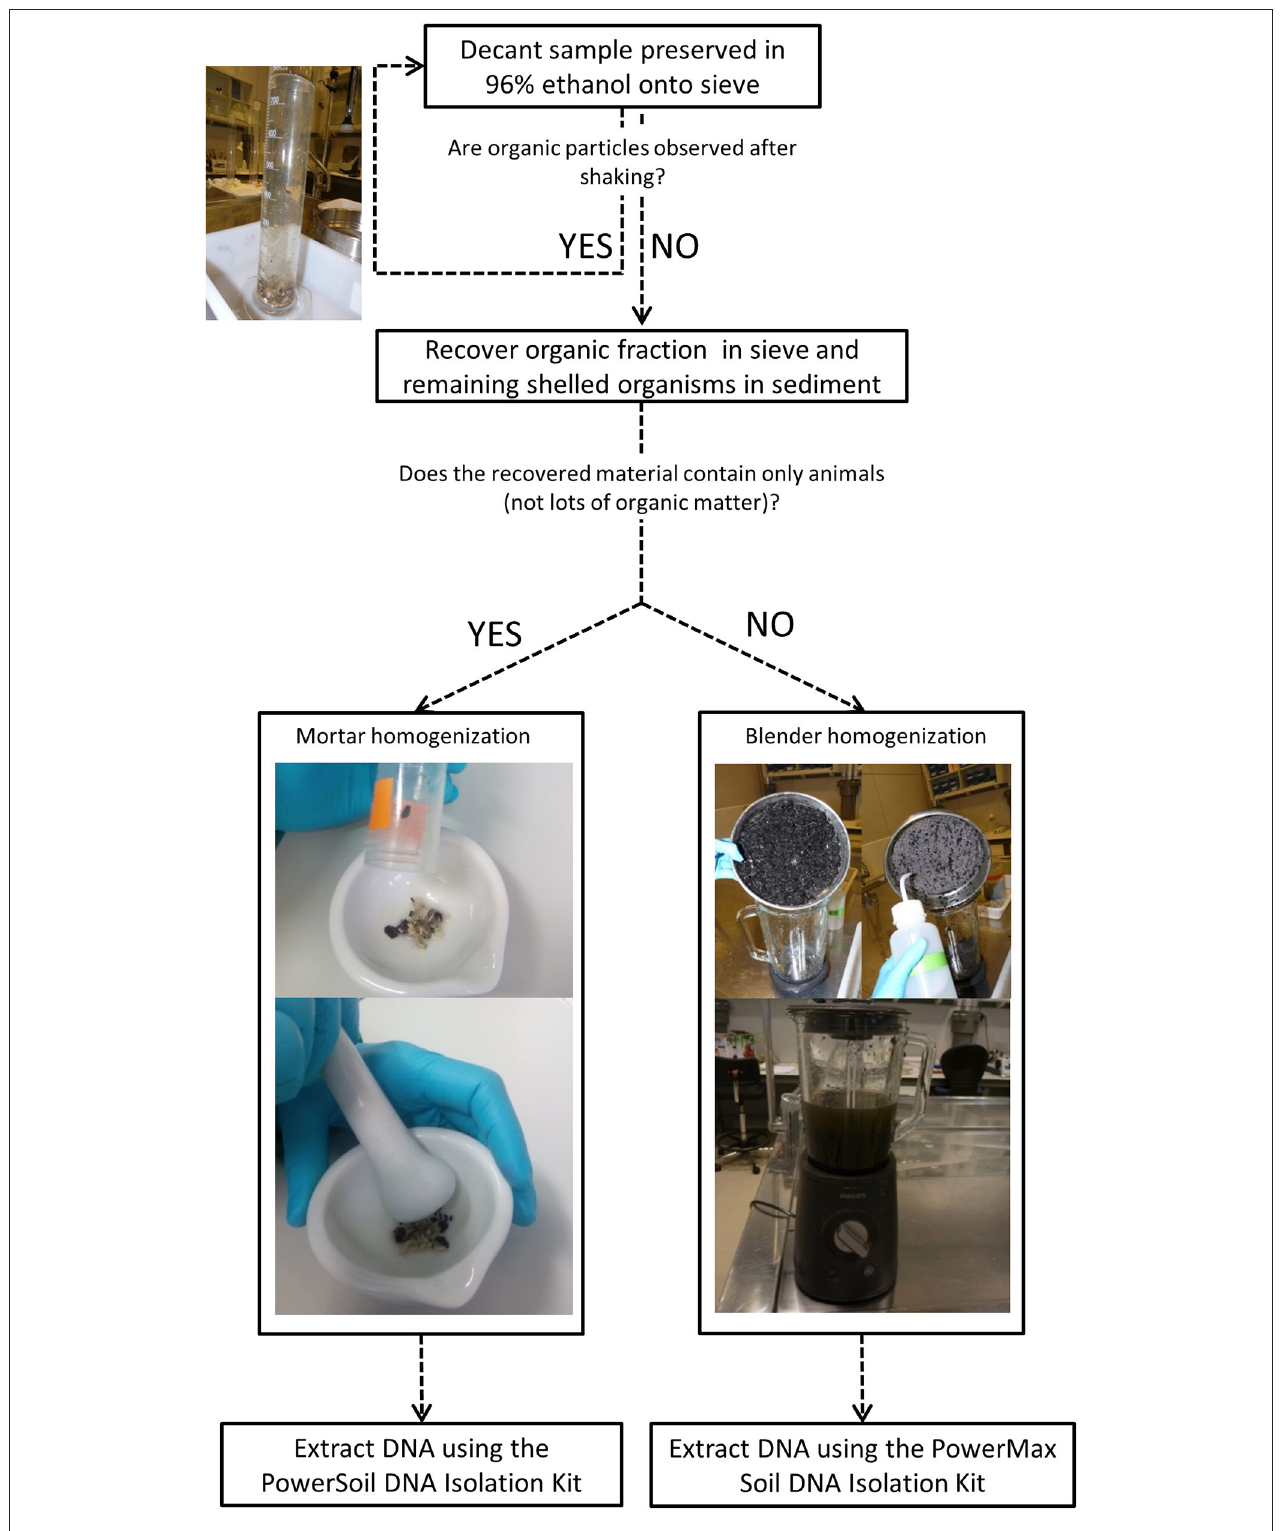
FIGURE 2 | Illustration of workflow for bulk sample